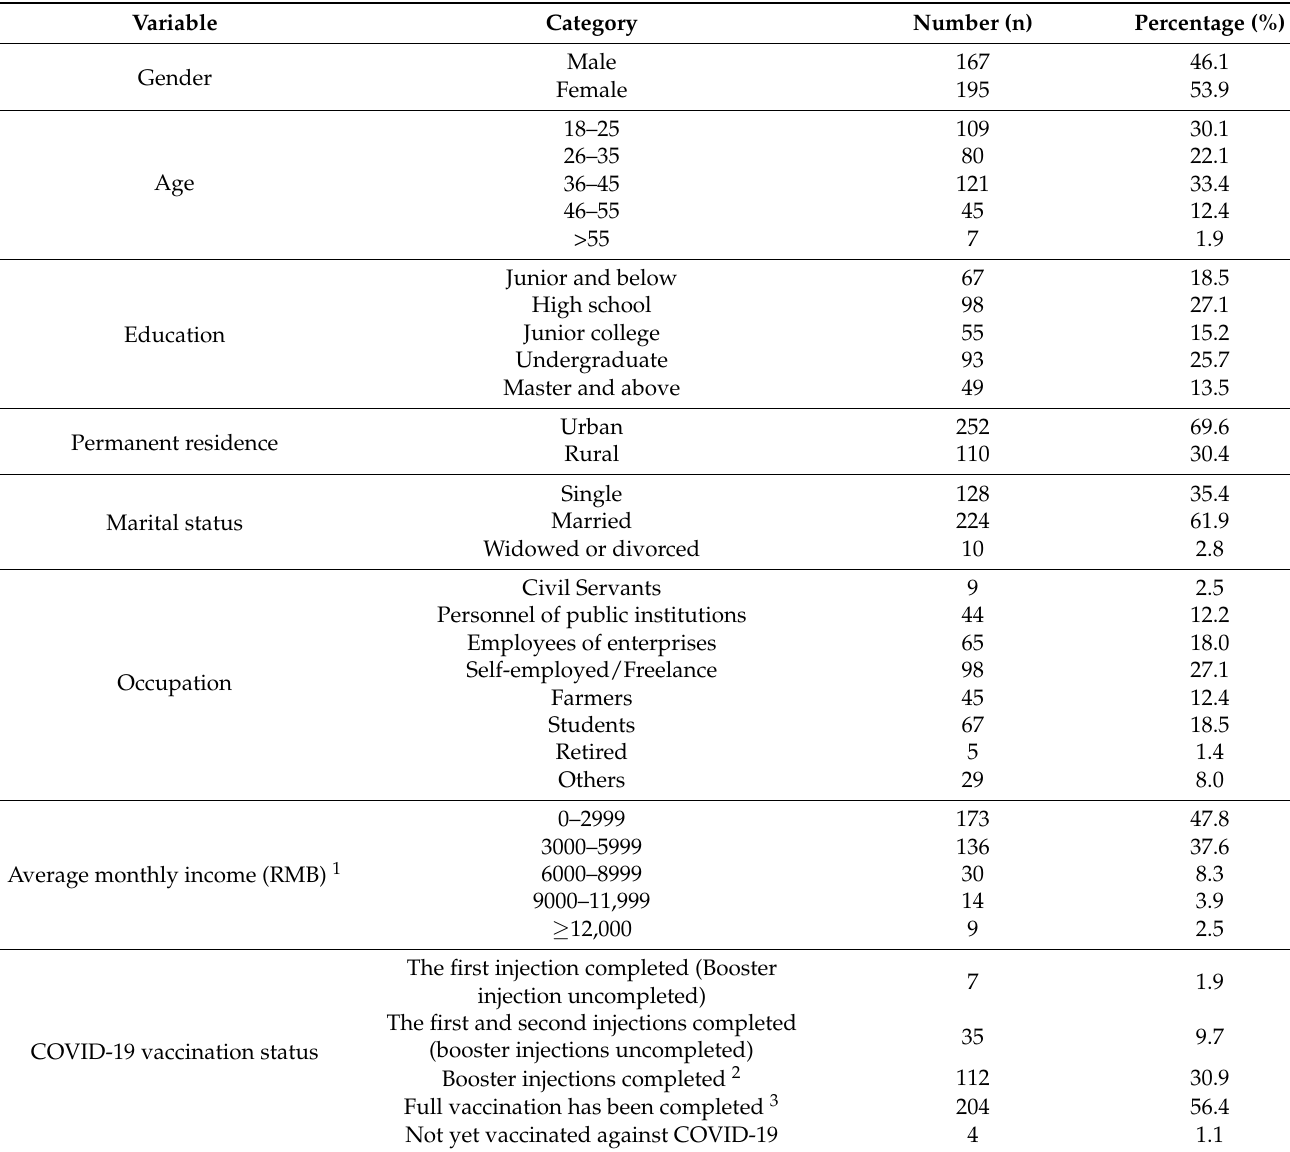
Table 2. Sociodemographic characteristics of the participants in this